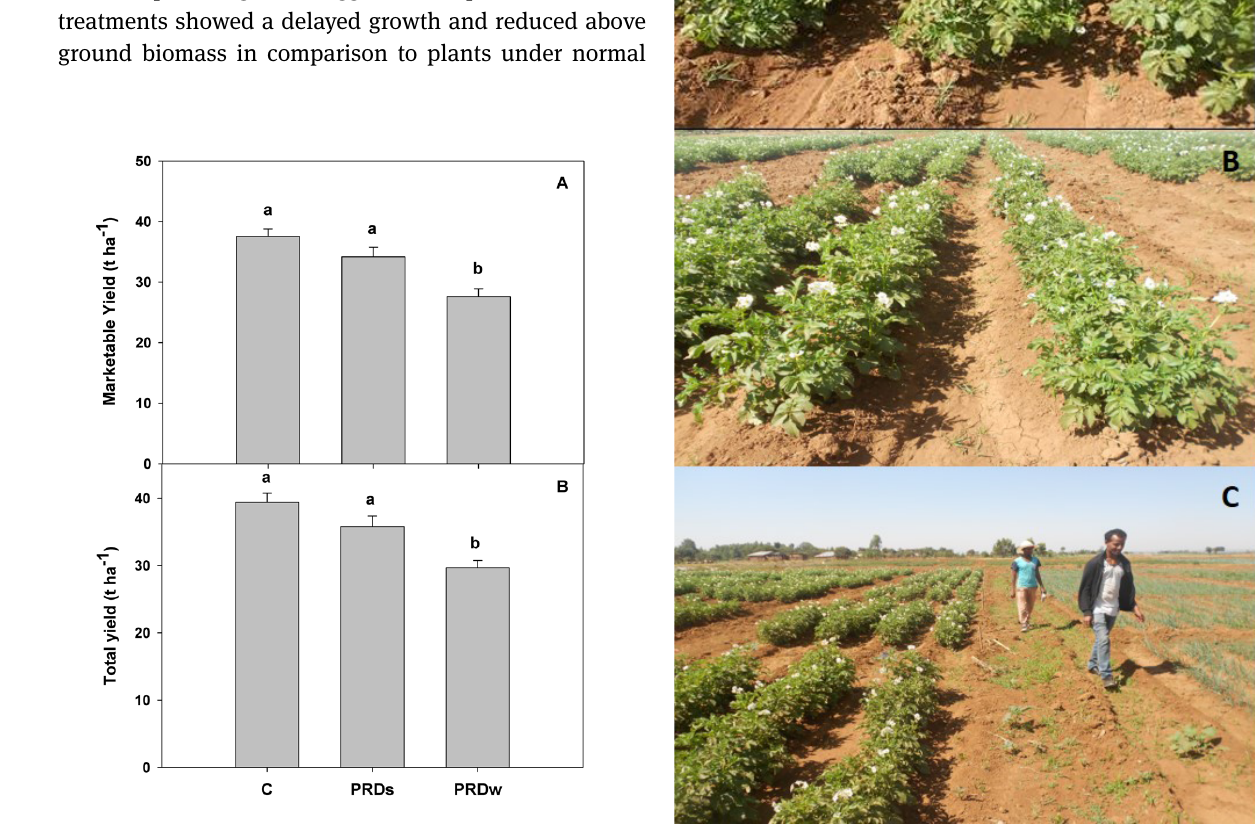
Figure 2. Mean (± standard error) marketable (A) and total (B) tuber yield per irrigation treatment. Different letters indicate differences (P < 0.05) detected by Scott-Knott test. C = Customary irrigation, PRDs = partial root-zone drying with siphons, PRDw = partial root- zone drying without siphons